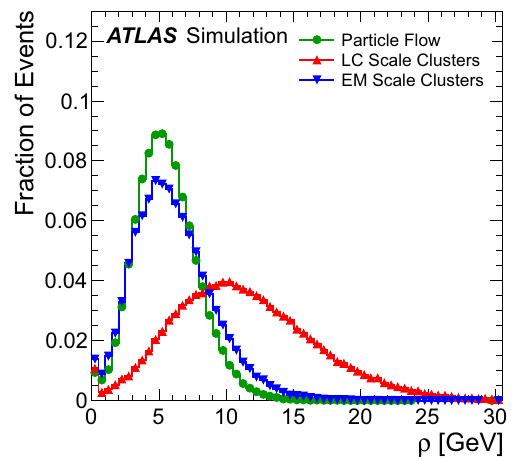
Fig. 23 The distribution of the median transverse energy density ρ in dijet MC simulated events with similar pile-up to that measured in the 2012 data for different jet